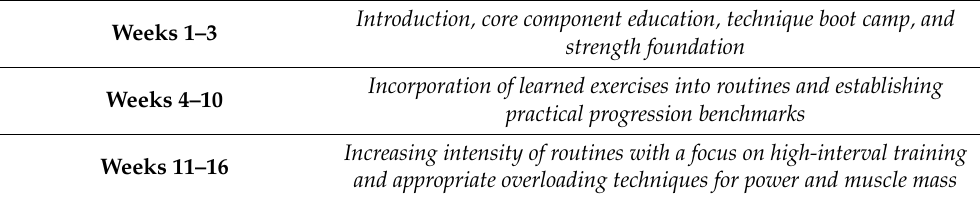
Table 1. General training progression